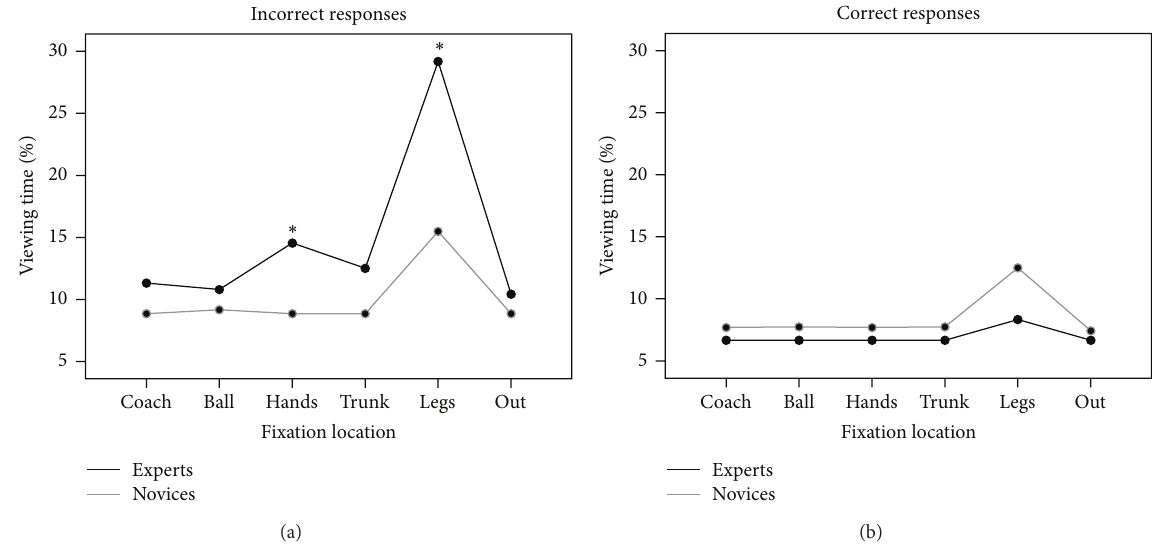
Figure 4: Mean percentage of time spent by subjects viewing each fixation location for the correct and incorrect responses across groups. Black lines = experts; gray lines = novices. Asterisks show significant differences ( 𝑃 < .001